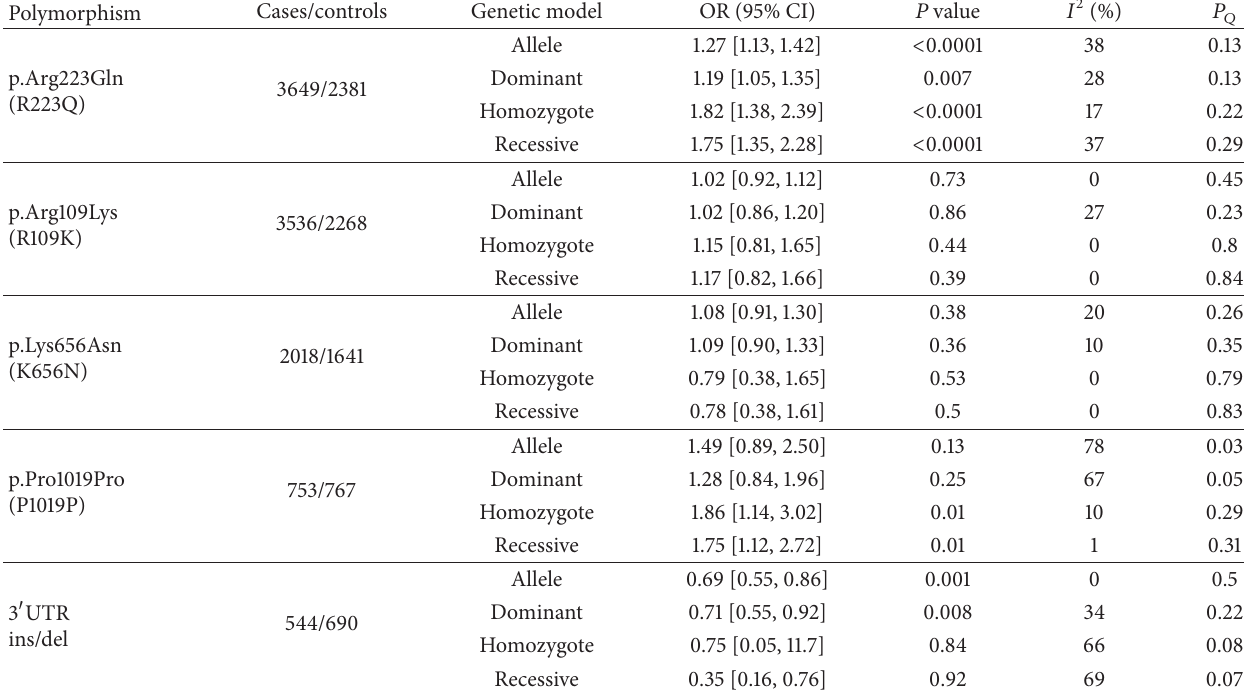
Table 2: Pooled analyses on the association of LEPR gene polymorphisms with